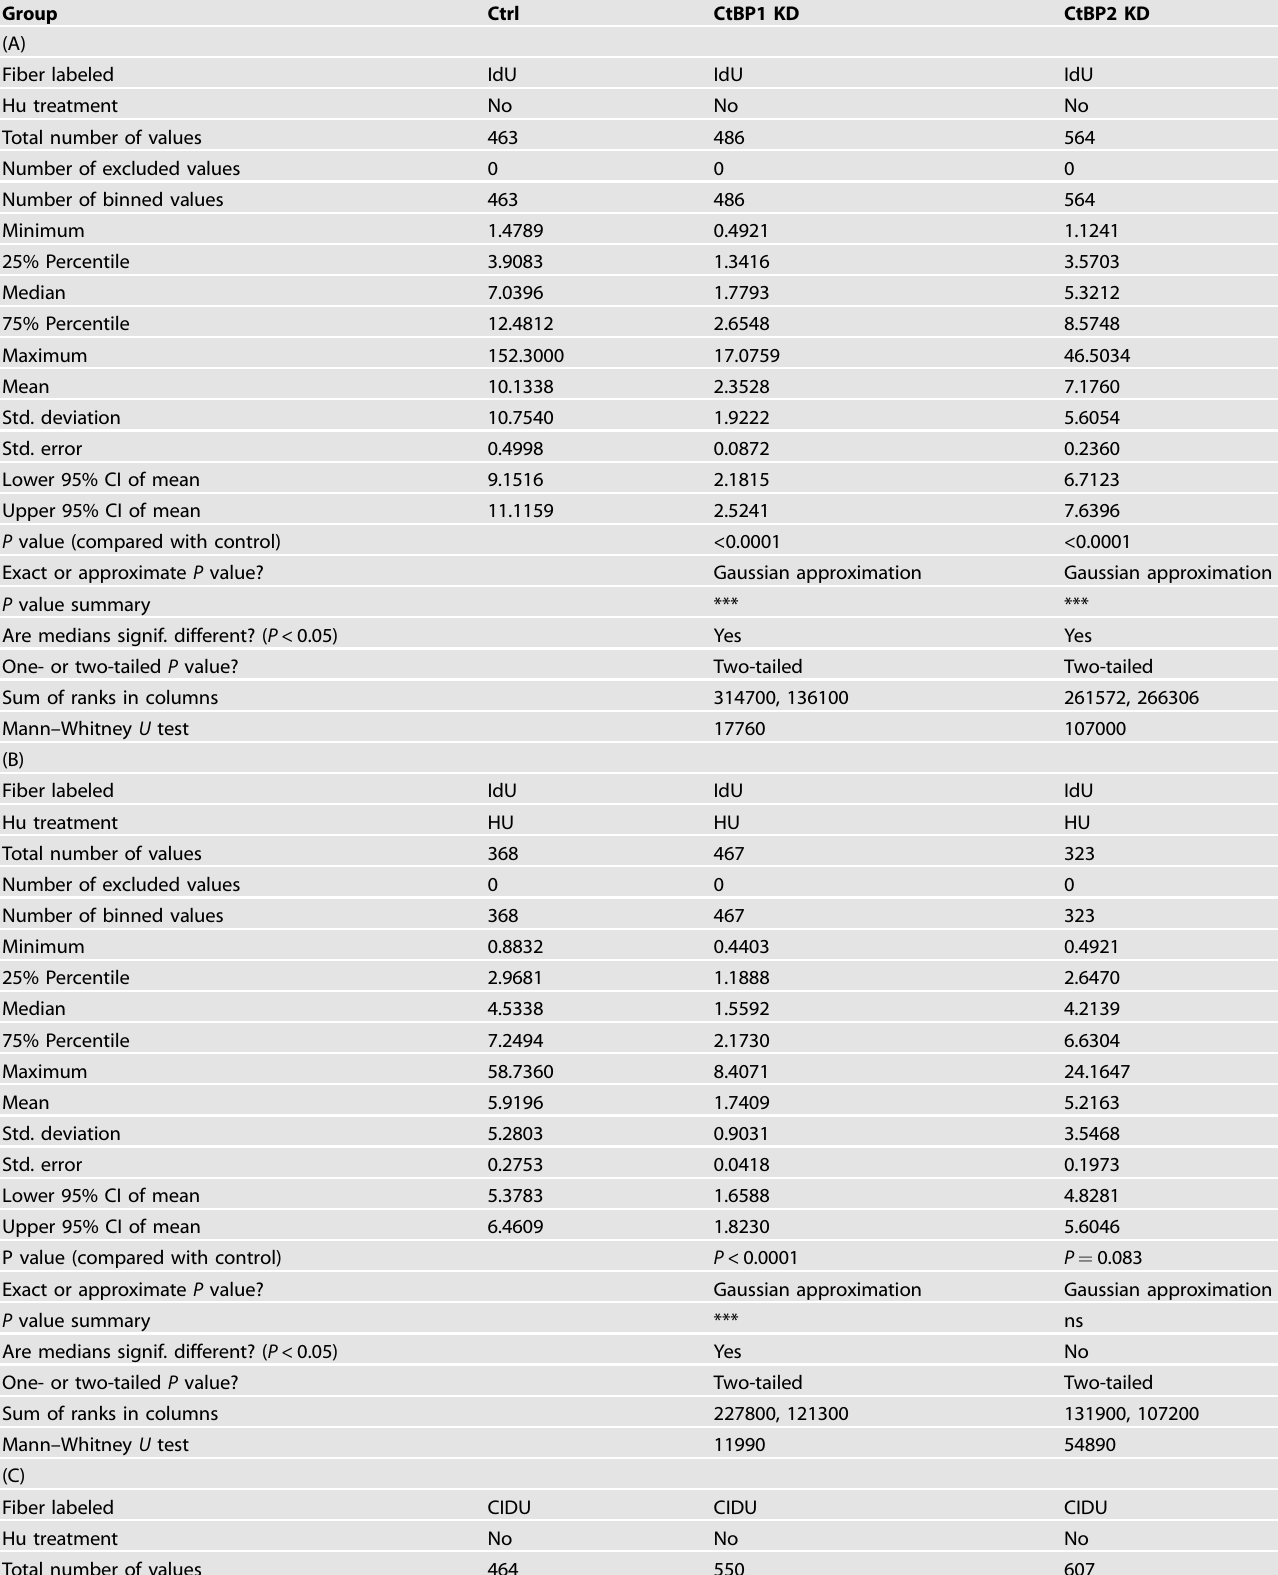
Table 1. The histogram comparison of IdU/CIdU labeled track among different groups.